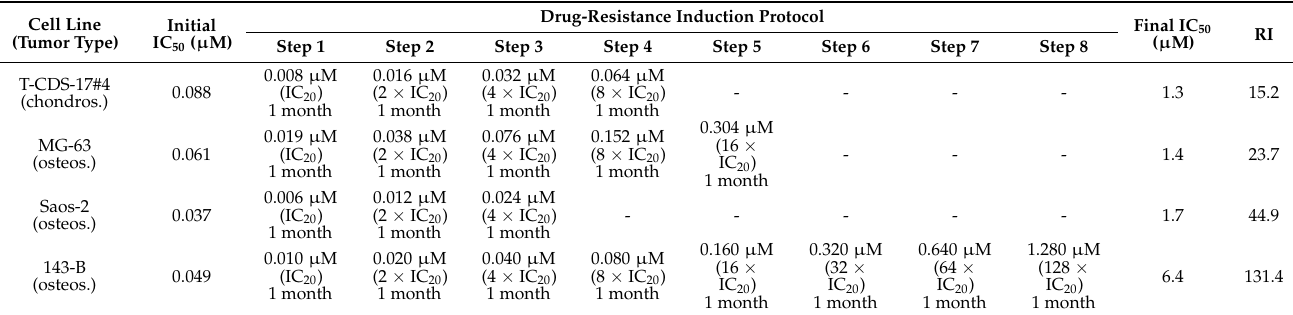
Table 1. Generation of DOX-resistant bone sarcoma cell lines.